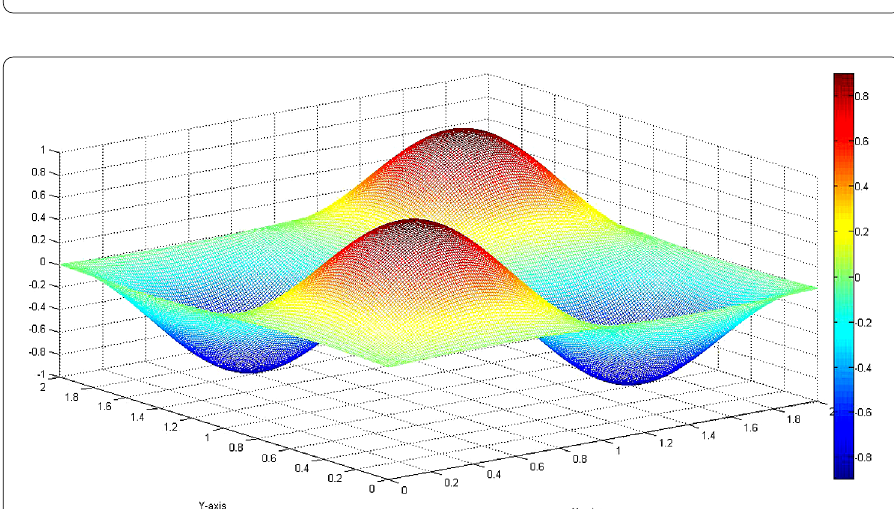
Figure 1 The classical FDCN solution at t = 0.1.